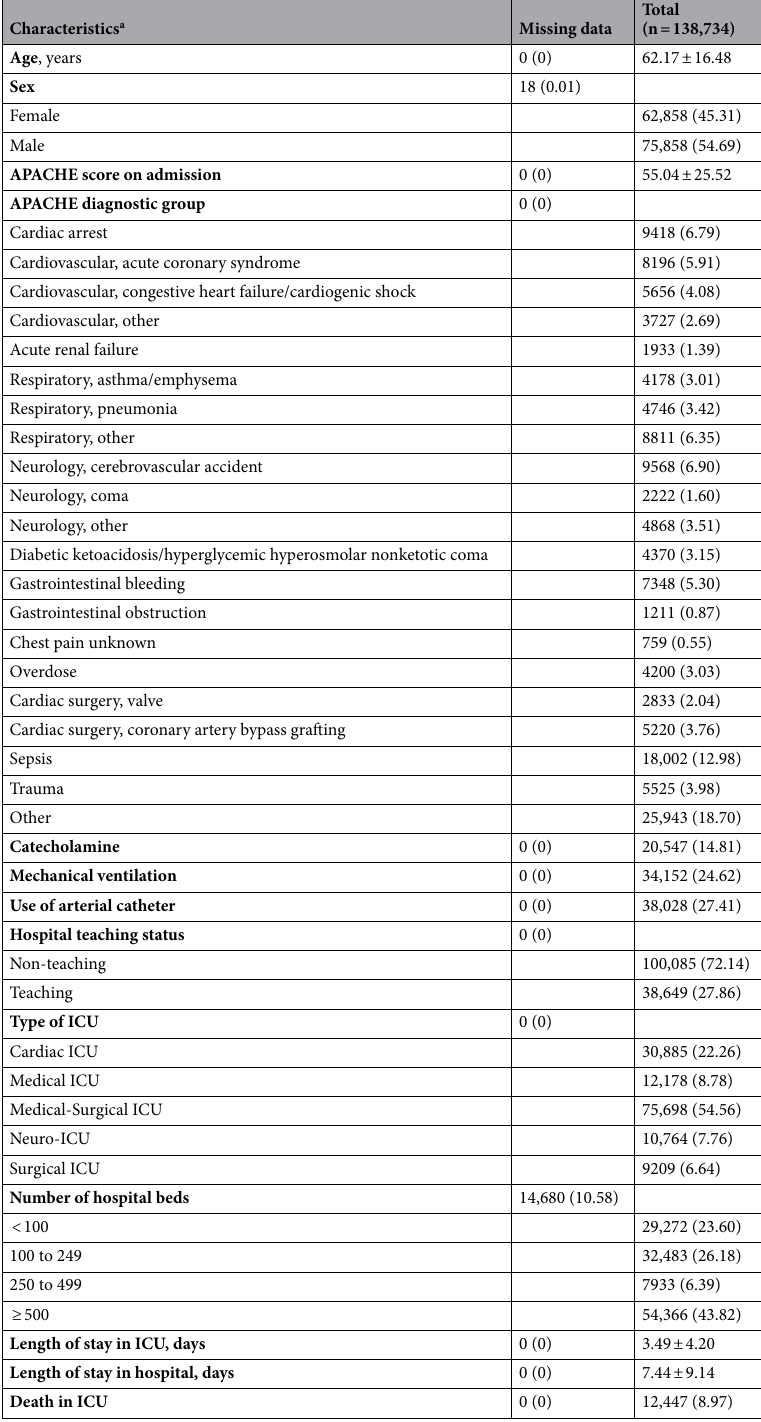
Table 1. Patient stays and intensive care unit characteristics. APACHE, Acute Physiology and Chronic Health Evaluation; ICU, Intensive Care Unit. a Results are expressed as n (%) or mean ± standard